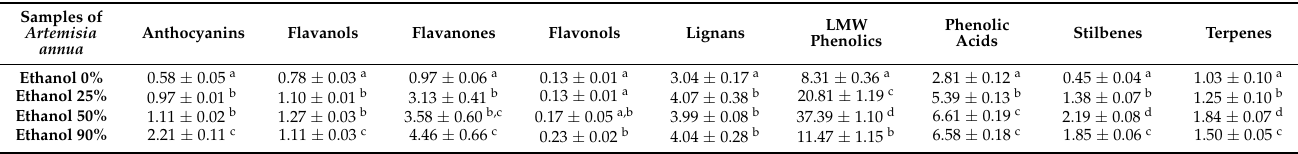
Table 2. Semi-quantitative values of bioactive compound classes considering four hydroalcoholic phyto-extracts of Artemisia annua